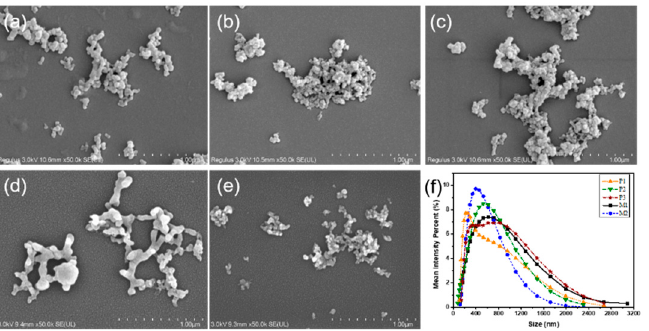
Figure 1. FE-SEM images of different lignin isolated from p -toluenesulfonic acid and maleic acid hydrolysis under different reaction conditions. ( a ) P1; ( b ) P2; ( c ) P3; ( d ) M1; ( e ) M2. Magnification: 50000×. ( f ) Mean intensity percent of different LNP size.